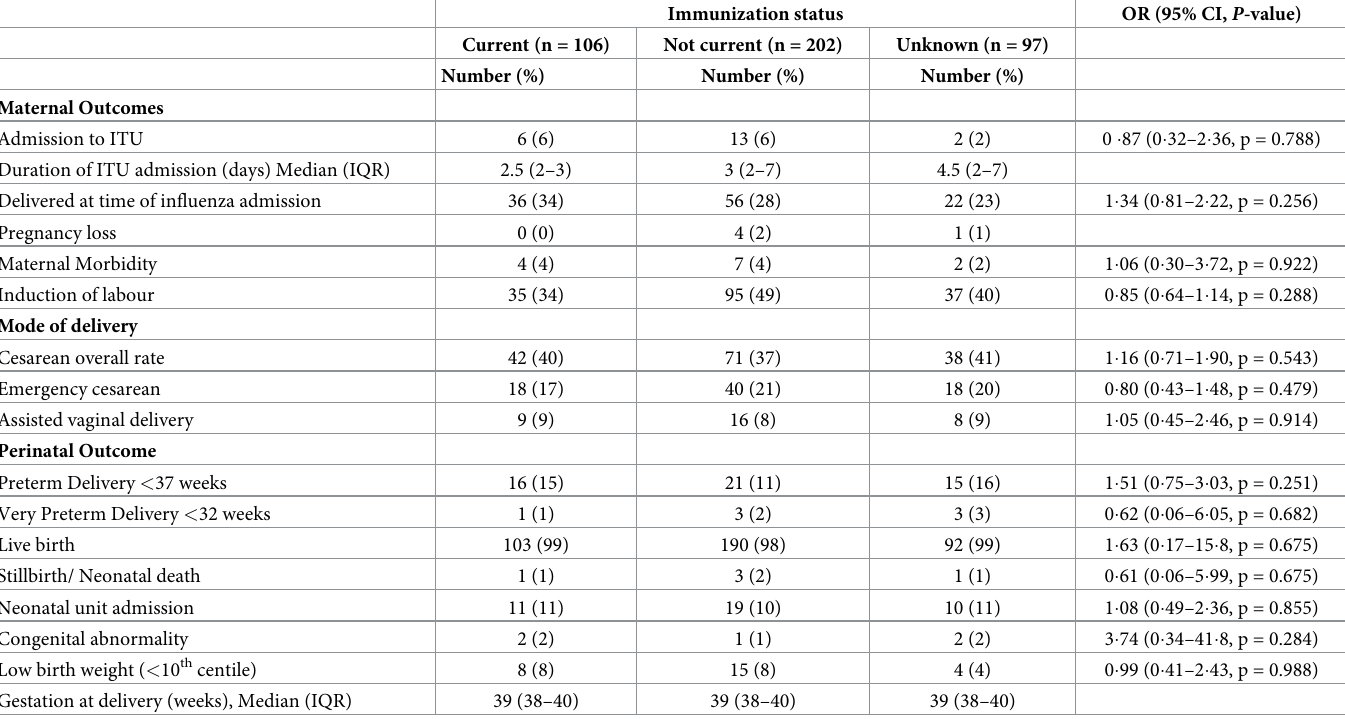
Table 3. Maternal and perinatal outcomes following seasonal influenza in pregnancy outcomes by immunization